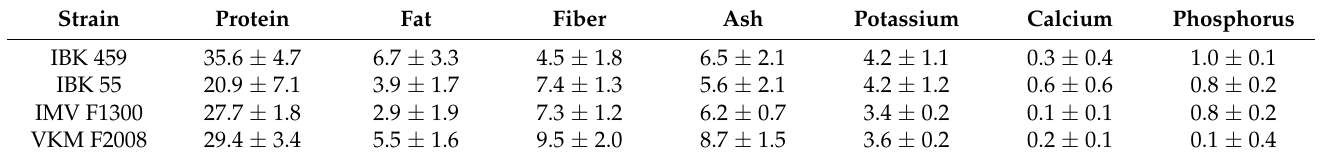
Table 2. Chemical composition of the biomass of the studied basidiomycete species,